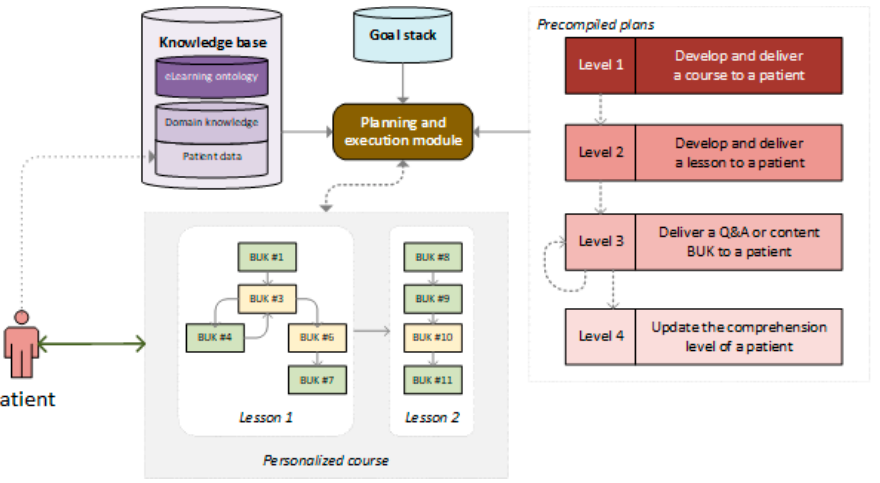
Figure 4. Architecture of the planning and execution framework for developing and delivering personalized courses.